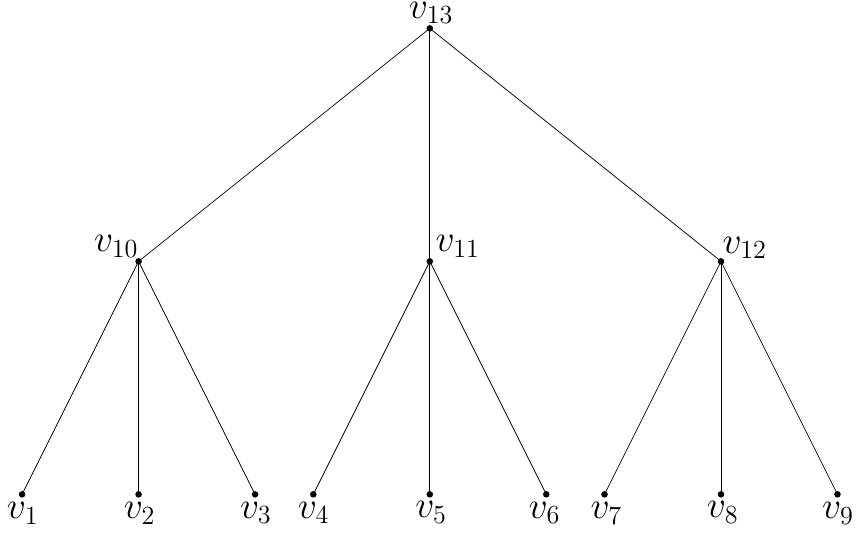
Figure 8. Balanced ternary